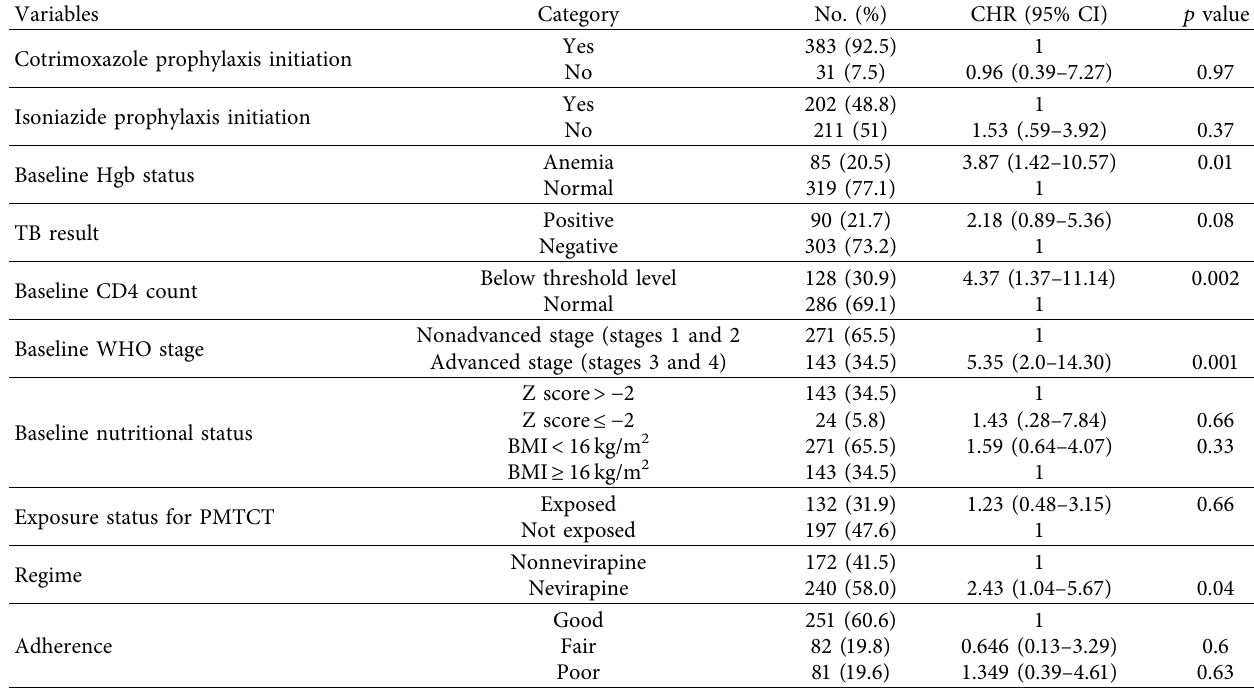
Table 4: Bivariable Cox regression analysis for clinical determinants of survival among children who started ARTat public health facilities between January 1, 2011, to December 30, 2015, at Shashamene town, Oromia region,